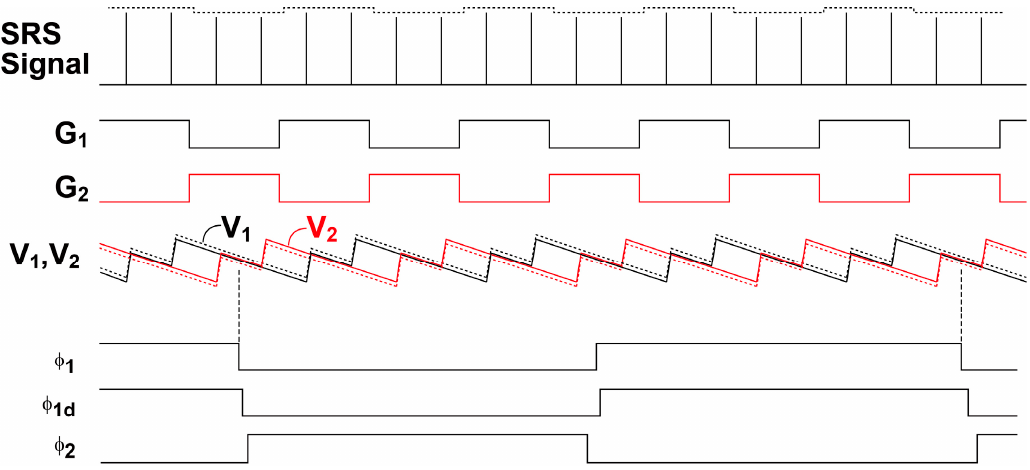
Figure 8. Timing diagram for the lock-in pixel operations.